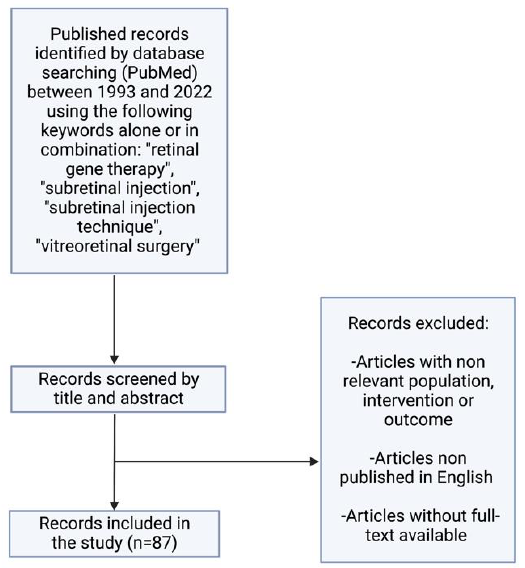
Figure 2. Flowchart diagram related to searching process.